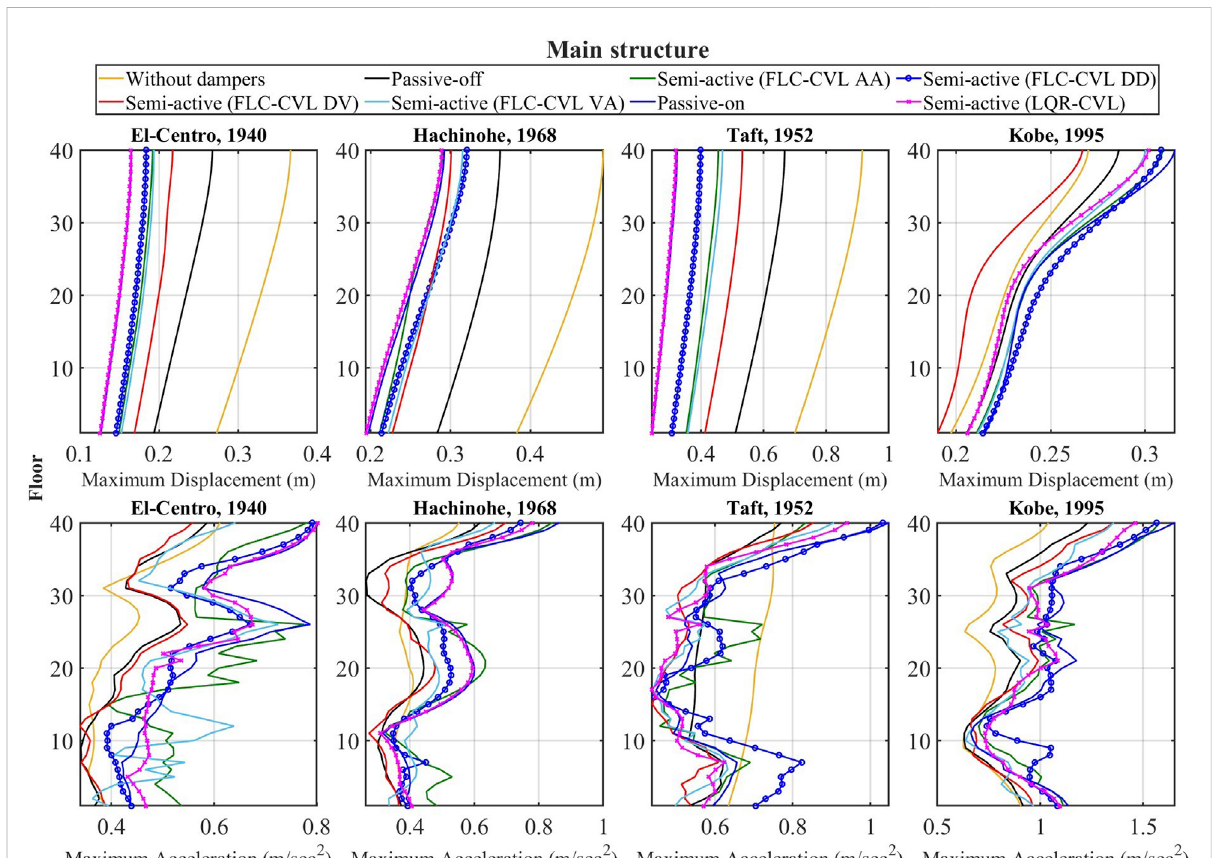
FIGURE 11 Maximum responses pro fi les of the main